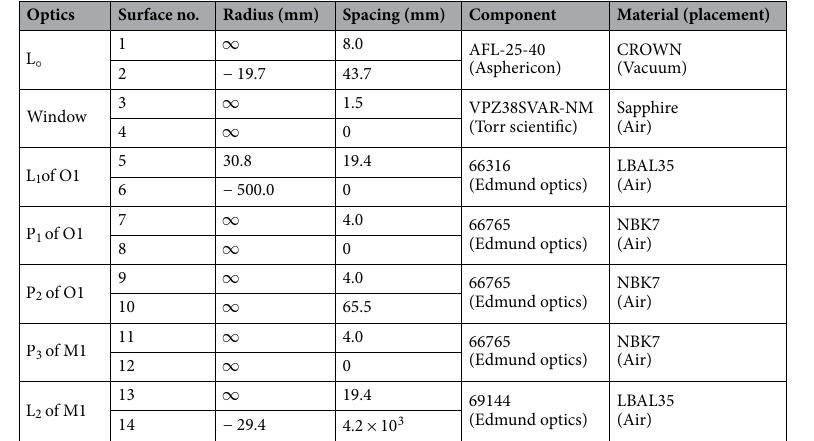
–O1–M1 lens system. ◦